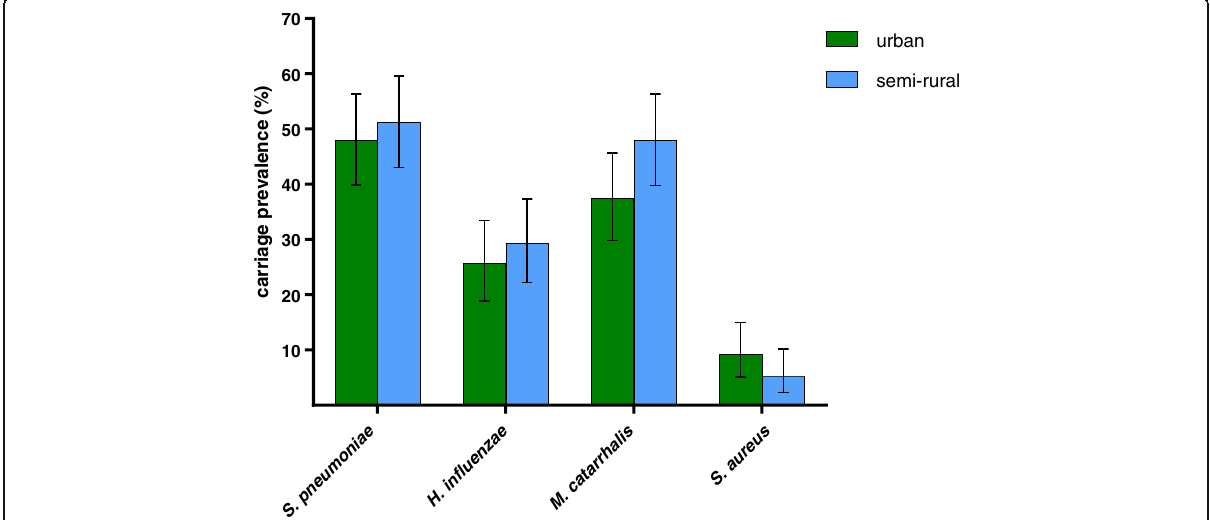
Fig. 1 Nasopharyngeal carriage prevalence of potentially pathogenic bacteria in Indonesian children aged 12 – 24 months living in urban (green) or semi-rural (blue) areas. Error bars depict 95% confidence